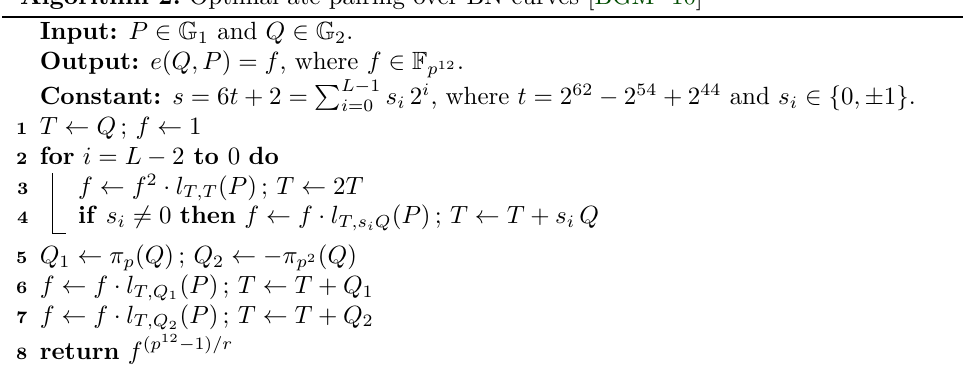
Algorithm 2: Optimal ate pairing over BN curves [BGM +